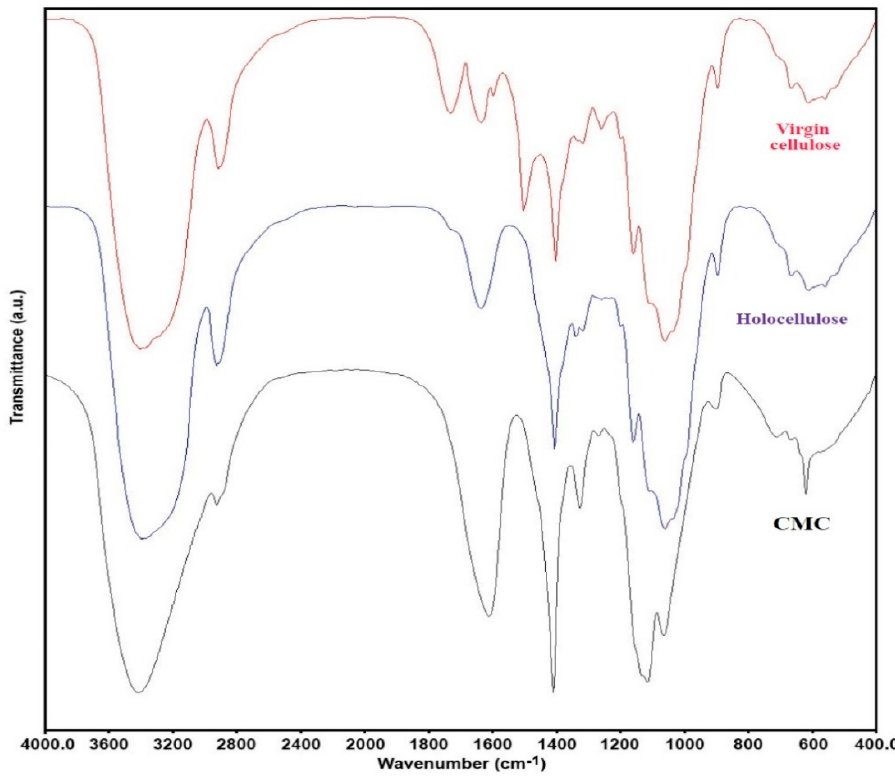
Figure 5. Structural properties of holocellulose and CMC (with degree of substitution 1.83). FTIR spectra of virgin cellulose, isolated holocellulose, and synthesized CMC.